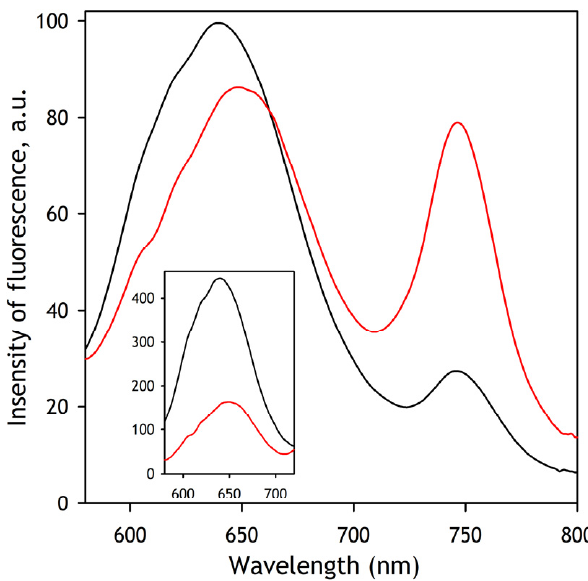
Figure A2. Spectra of fluorescence of SbCPR-2DY (red) and an equimolar mixture of single labeled SbCPR-DY520XL with SbCPR double-labeled with MBBR and DY-731 (black) taken at 5 °C with excitation at 505 nm. The spectra shown in the main panel are normalized to the same integral intensity of fluorescence. The inset shows the donor emission bands unscaled.